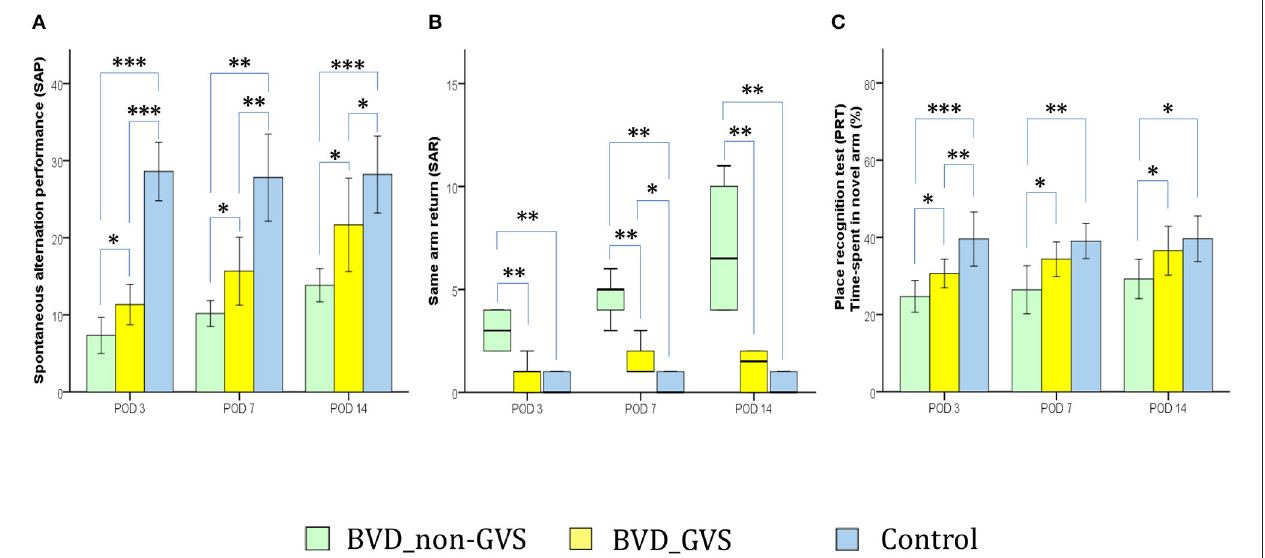
FIGURE 3 | Evaluation of locomotor activity and spatial navigation in the Y maze test. The spontaneous alternation performance (SAP), an indicator of spatial working memory and locomotor activity, was decreased in the BVD_non-GVS group compared with the control group on PODs 3 ( p < 0.001, Bonferroni test), 7 ( p < 0.001, Tamhane test), and 14 ( p < 0.001, Bonferroni test). The values of the BVD_GVS group were better than those of the BVD_non-GVS group on PODs 3 ( p = 0.018, LSD test), 7 ( p = 0.049, Tamhane test), and 14 ( p = 0.02, Bonferroni test) (A) . The same arm return (SAR), which indicates the degree of attentional difficulty during active working-memory performance, was significantly higher in the BVD_non-GVS group than in the control group on PODs 3 ( p = 0.005, Mann-Whitney U test), 7 ( p = 0.005, Mann-Whitney U test), and 14 ( p = 0.005, Mann-Whitney U test). The BVD_GVS group showed better values than the BVD_non-GVS group on PODs 3 ( p = 0.006, Mann-Whitney U test), 7 ( p = 0.004, Mann-Whitney U test), and 14 ( p = 0.003, Mann-Whitney U test) (B) . In the PRT, an indicator of spatial reference memory, the BVD_non-GVS group scored significantly worse than the control mice on PODs 3 ( p < 0.001, Bonferroni test), 7 ( p = 0.002, Bonferroni test), and 14 ( p = 0.017, Bonferroni test). The PRT performance improved significantly in the BVD_GVS group, compared with the BVD_non-GVS group, on PODs 3 ( p = 0.033, LSD test), 7 ( p = 0.038, Bonferroni test), and 14 ( p = 0.031, LSD test) (C) . The SAP and PRT values are given as the mean ± SD, and the p values were